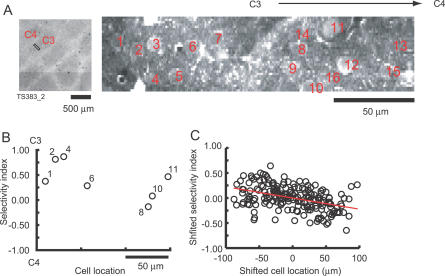
Somatotopy at the Level of Single Cells(A) Left: the location of the imaged area in CO-stained barrels. Right: Fluo-4 AM image showing the locations of the analyzed cells. The imaged area was centered on the C3 barrel, with the C4 barrel to the right.(B) The SI of neurons in (A) as a function of their location. Only cells without overlap (Φ = 0) were included in the analysis.(C) Spatial changes in the selectivity index across 33 experiments. To overlay different experiments the SI and location were shifted so that the center of gravity of the data points was on the origin.